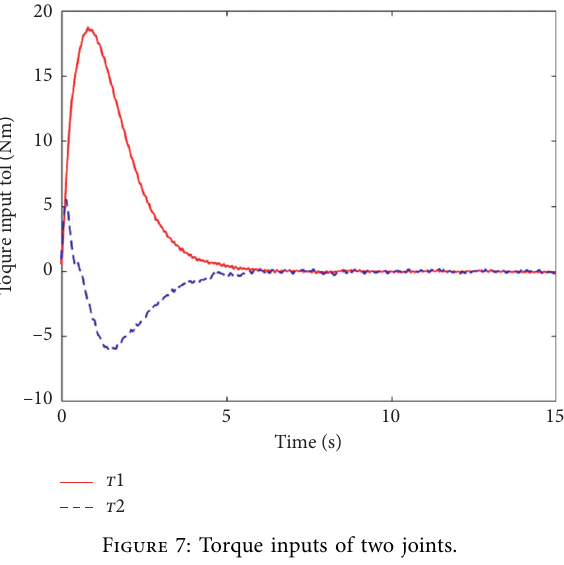
Figure 3: Actual joint angles.